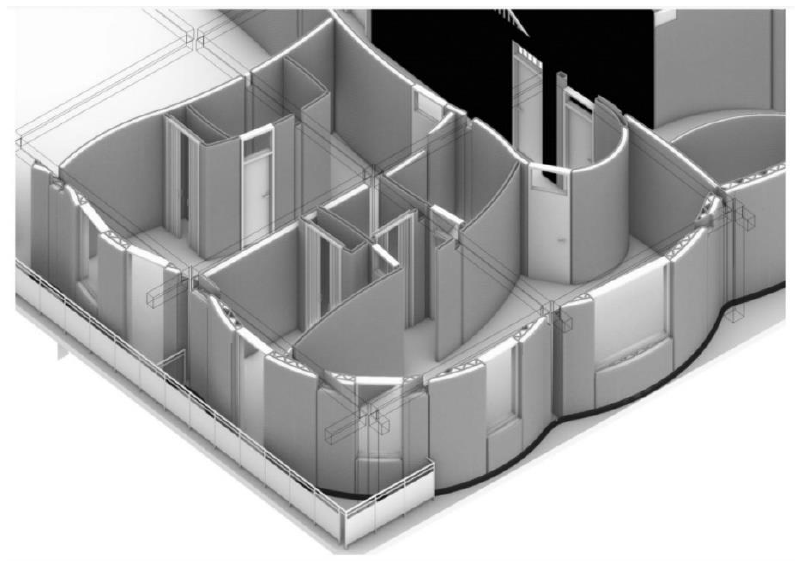
Figure 5. Example of a building model with indoor partitions and outdoor envelope with 3D-printed walls (Source: authors).